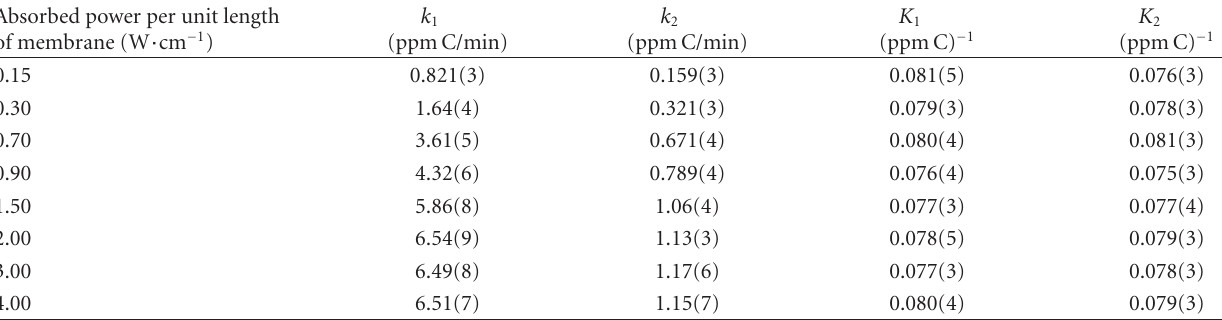
♥ Uncertainties are indicated between parentheses and expressed, relatively to the last digits, as probable errors of the means of optimised values from nine sets of runs in the range of concentrations